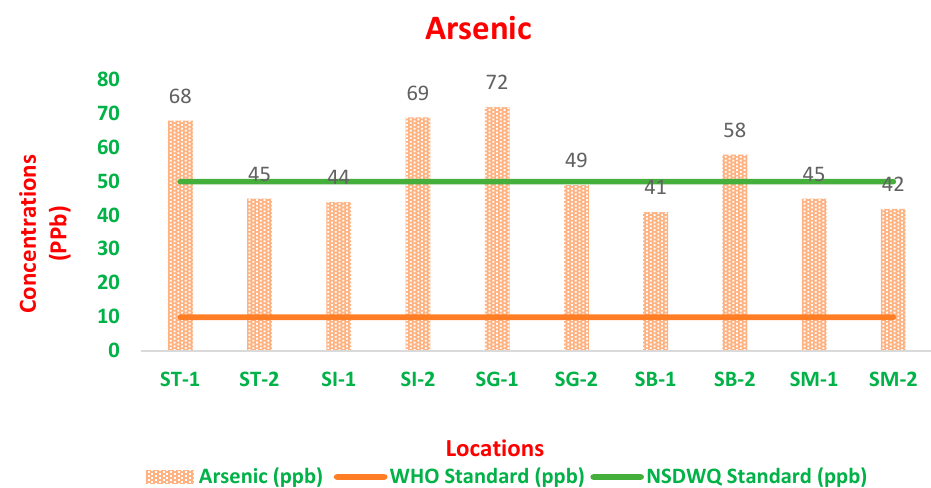
Figure 4. Arsenic in drinking water at selected locations, of Lahore, Pakistan.